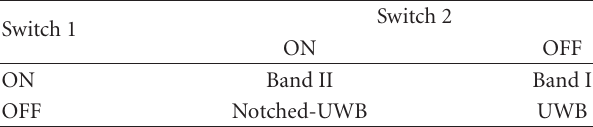
Table 1: Operation modes of the